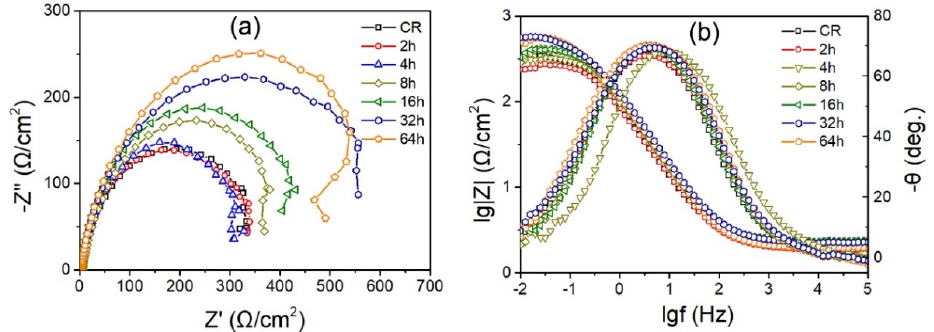
Figure 7. Nyquist plots ( a ) and Bode plots ( b ) of various annealed IF steel specimens.